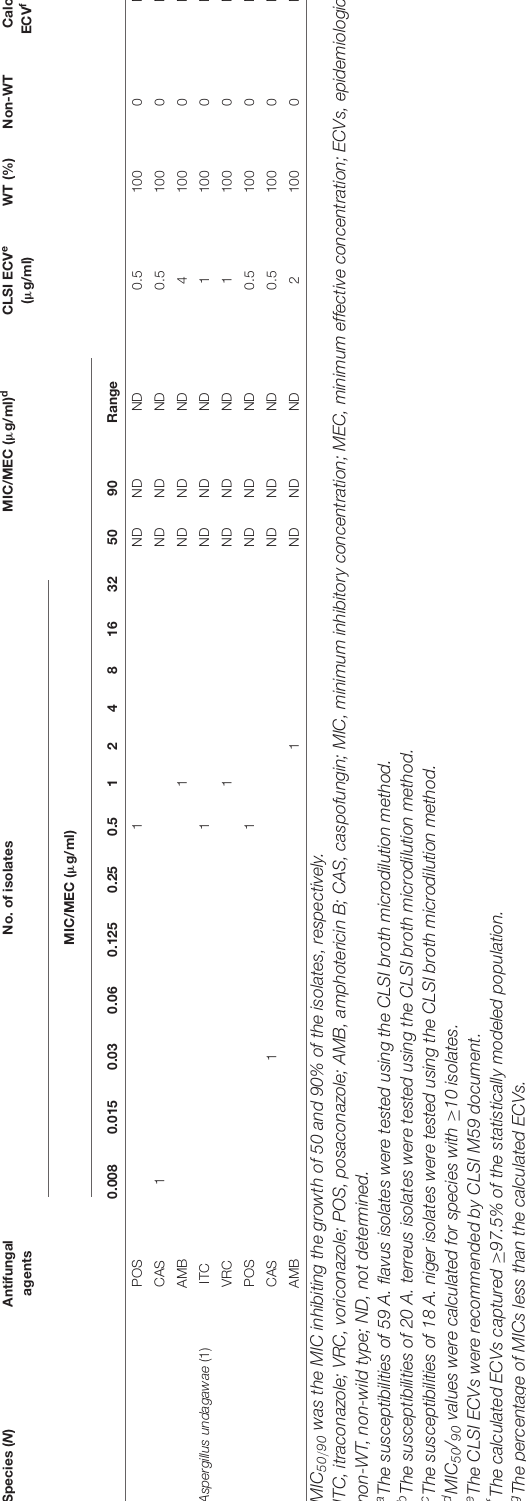
Number (%) of isolates with resistance to